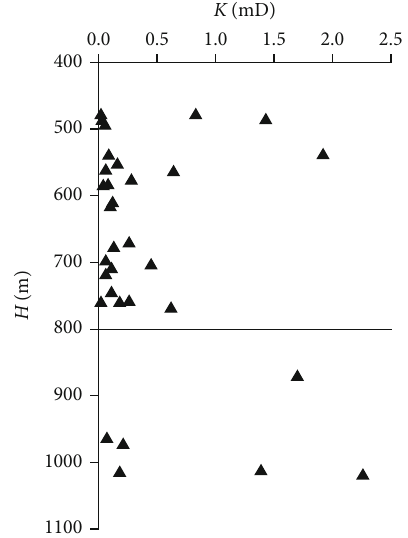
Figure 8: Scatter diagram of permeability and burial